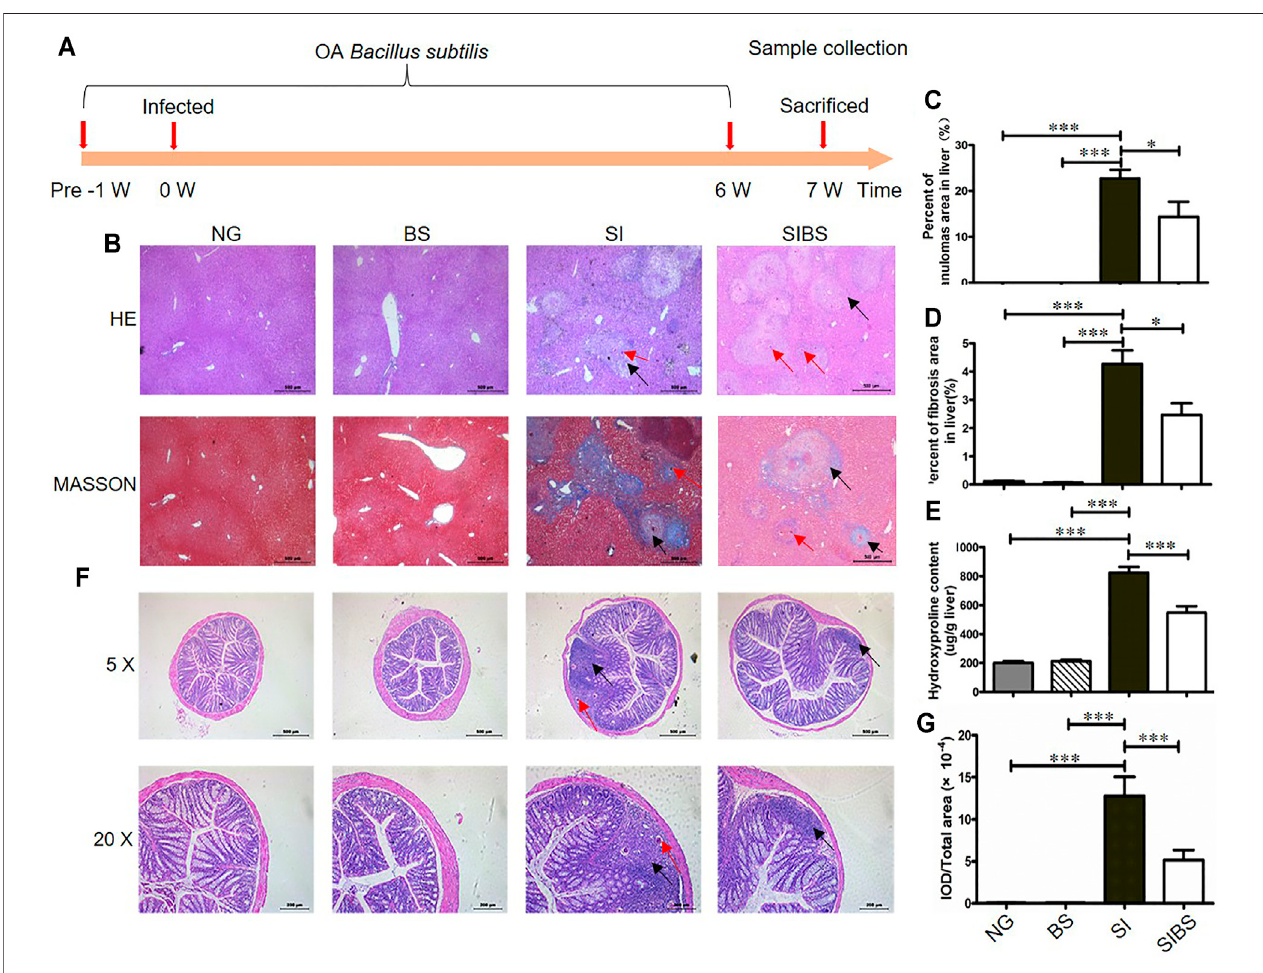
FIGURE 1 | OA B. subtilis attenuated S. japonicum – induced hepatic and intestinal granulomas in mice ( n (cid:2) 6). (A) Time schedule for parasite infection, OA B. subtilis ,andsamplecollection.Micewereinfectedwith20 ± 2 S.japonicum cercariaeat0 weeks.Infectedmicereceived B.subtilis atadoseof0.3 × 8 × 10 8 CFU/ mlor PBS at 1 week post-infection. Samples were collected at the indicated time points. (B) H&E staining and Masson ’ s trichrome staining of liver tissues. (C) The value of granuloma area in the liver. (D) The value of fi brosis area in the liver. (E) Hydroxyproline content in the liver. (F) H&E staining of colon tissues. (G) The value of granuloma area in the colon. Granulomatous responses in the colon were estimated by calculating the ratio of the integrated optical density (IOD) to the intestinal tissue area.NG:normal mice withPBSgroup. BS: normal mice with OA B. subtilis group. SI: S.japonicum – infected mice group. SIBS: S. japonicum – infected mice with OA B. subtilis group. Black arrows indicate granulomas or fi broses and red arrows indicate schistosome eggs. * and *** were considered statistically signi fi cant.